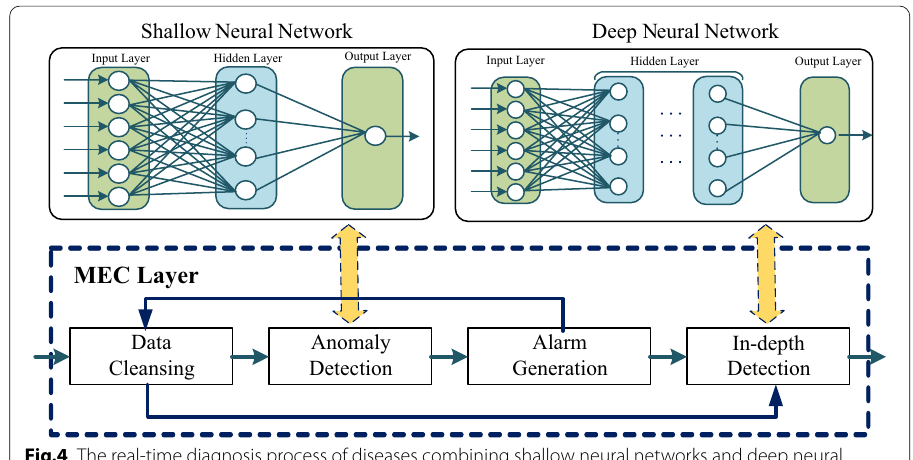
Fig.4 The real-time diagnosis process of diseases combining shallow neural networks and deep neural